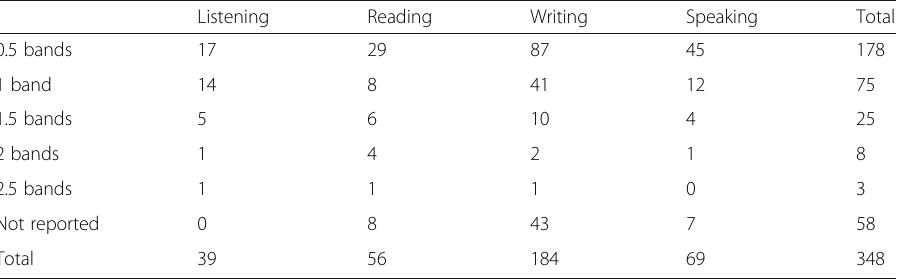
Table 4 Instances of candidate IELTS sub-test underperformance, correlating sub-test scores with the extent of band score deficit Listening